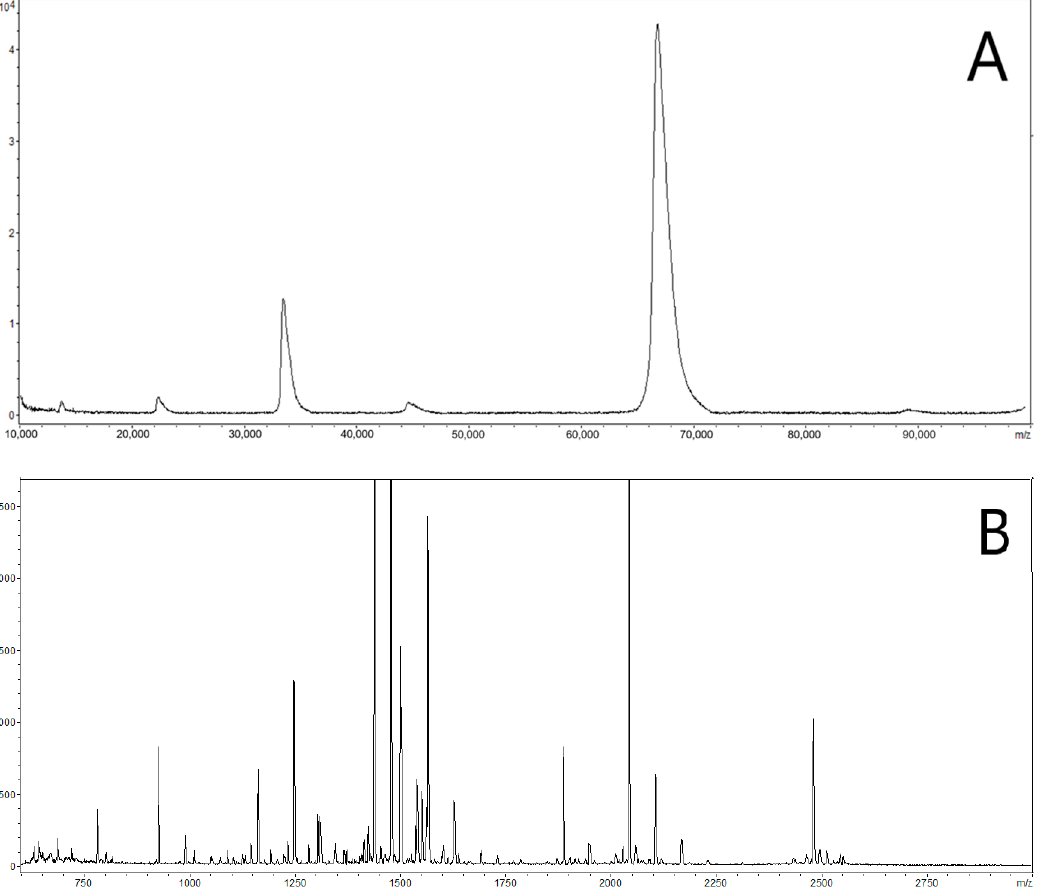
Figure 5. Mass spectra of untreated BSA ( A ) and BSA tryptic digest ( B ). The latter was collected on the same spot of the former, after the removal of SA matrix with a 70% methanol solution and on-chip digestion at 45–50 °C for 30 min.